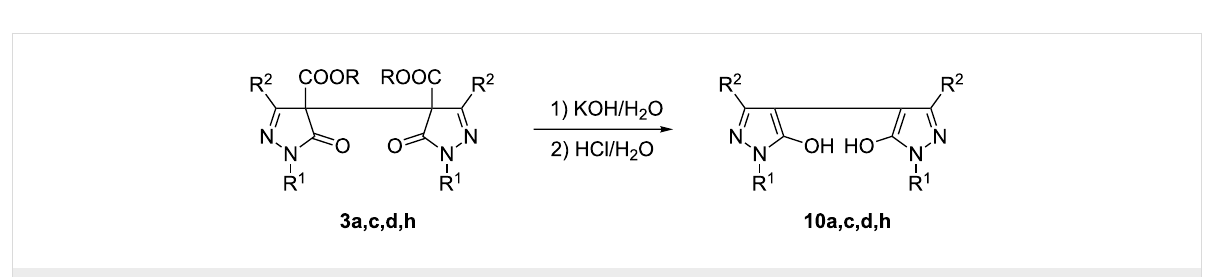
Scheme 7: Preparation of bipyrazoles 10 .